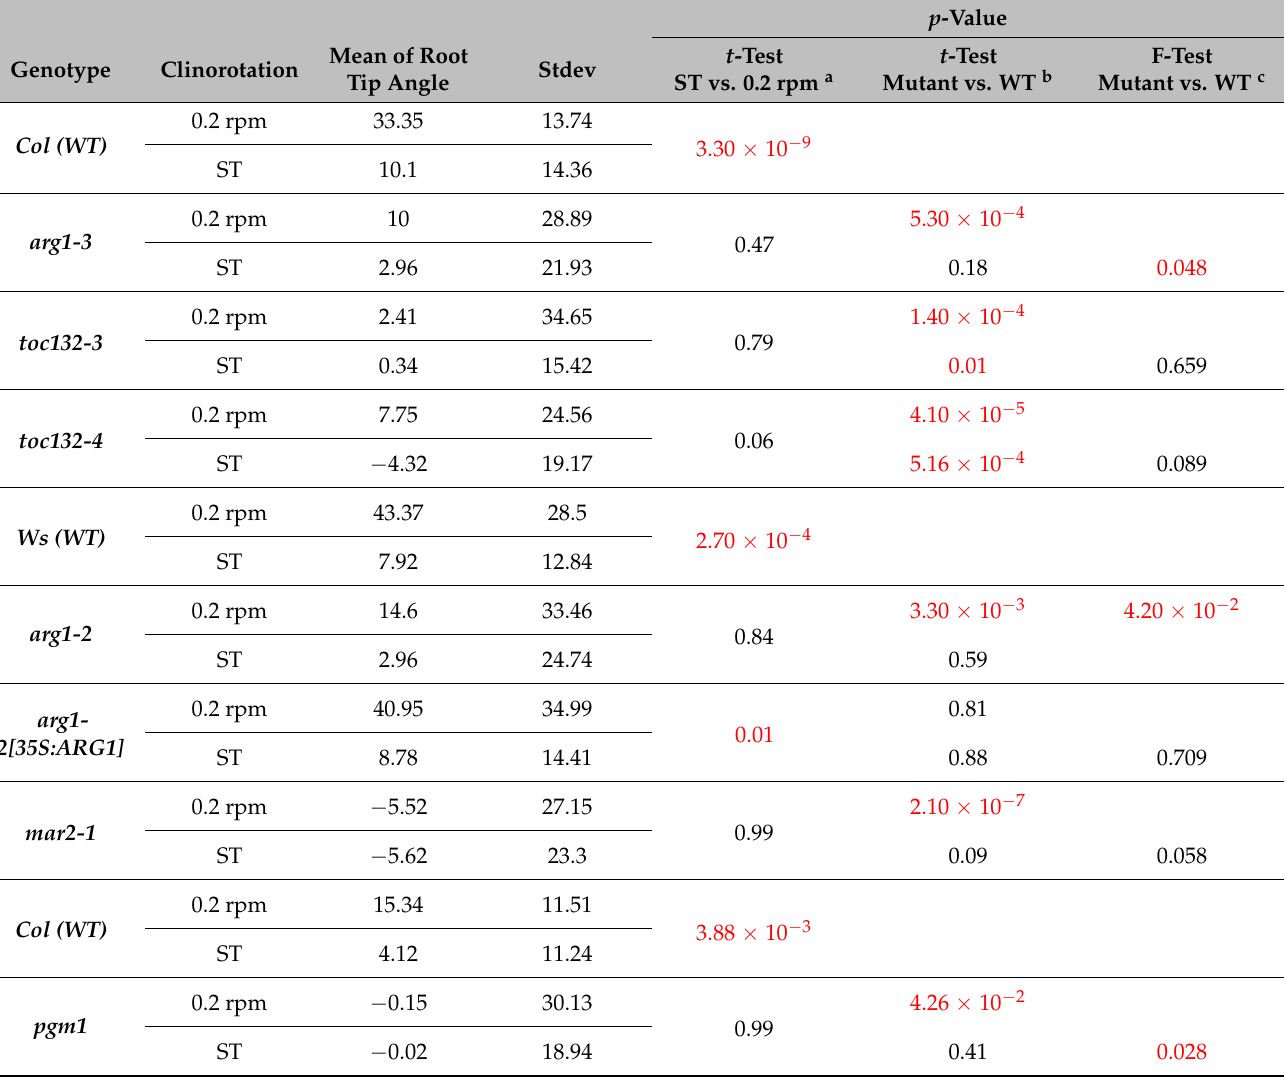
Table 1. Quantification of root-tip curvature responses to stationary growth (ST) or 0.2 rpm cli- norotation for wild type (Col and Ws) and gravitropism-deficient Arabidopsis mutants growing on agar surfaces. Mean root-tip angles and standard deviations are shown along with the p-values associated with statistical analyses of the significance of difference between samples. Panels (A) and (B) summarize the results of two independent